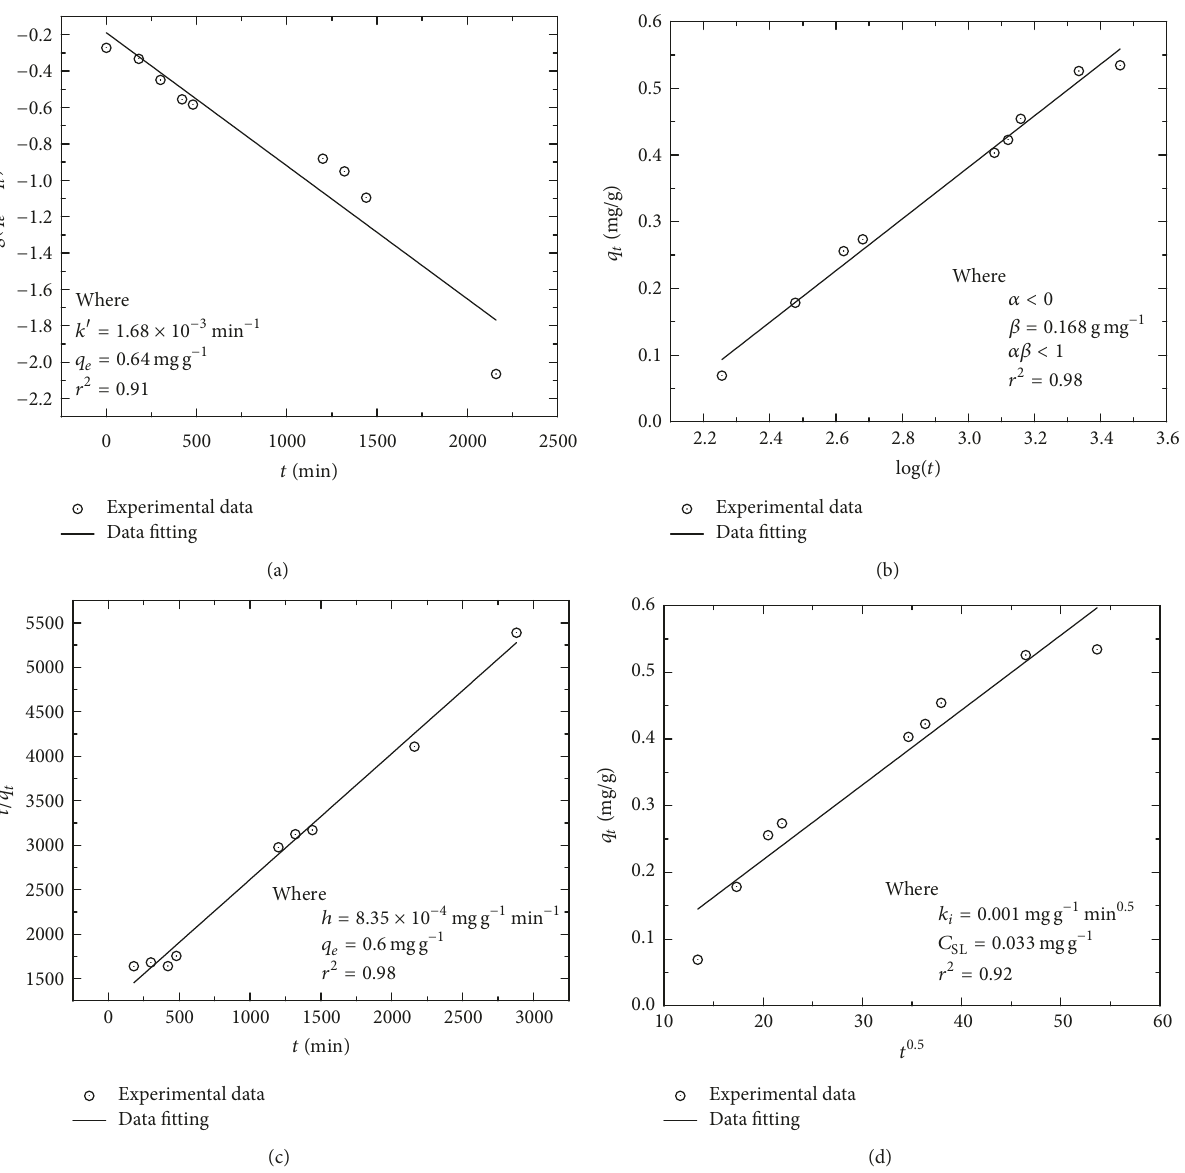
Figure 8: (a) Experimental data fit of the pseudo-first-order model (Lagergren’s equation); (b) experimental data fit using the linearized equation of the Elovich model, 𝑞 𝑡 = 𝛼 + 2.303𝛽 log (𝑡) ; (c) experimental data fit using the linearized equation of pseudo-second-order model proposed by Ho et al. (2005), 𝑡/𝑞 𝑡 = 𝑞/ℎ+(1/𝑞 𝑒 )𝑡 ; (d) experimental data fit using the linearized equation of the intraparticle diffusion